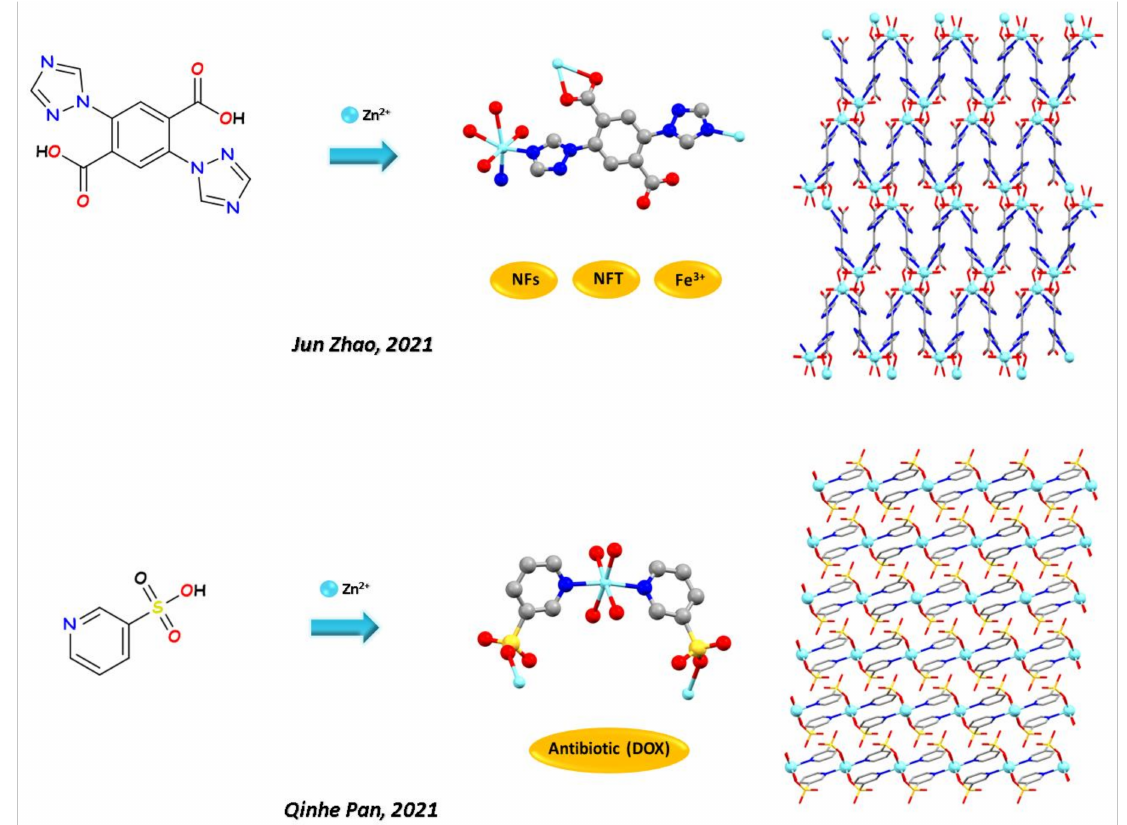
Figure 7. Some representative structures of Zn-CPs for sensing and delivery of bio-relevant species. Figures readapted by using Mercury software